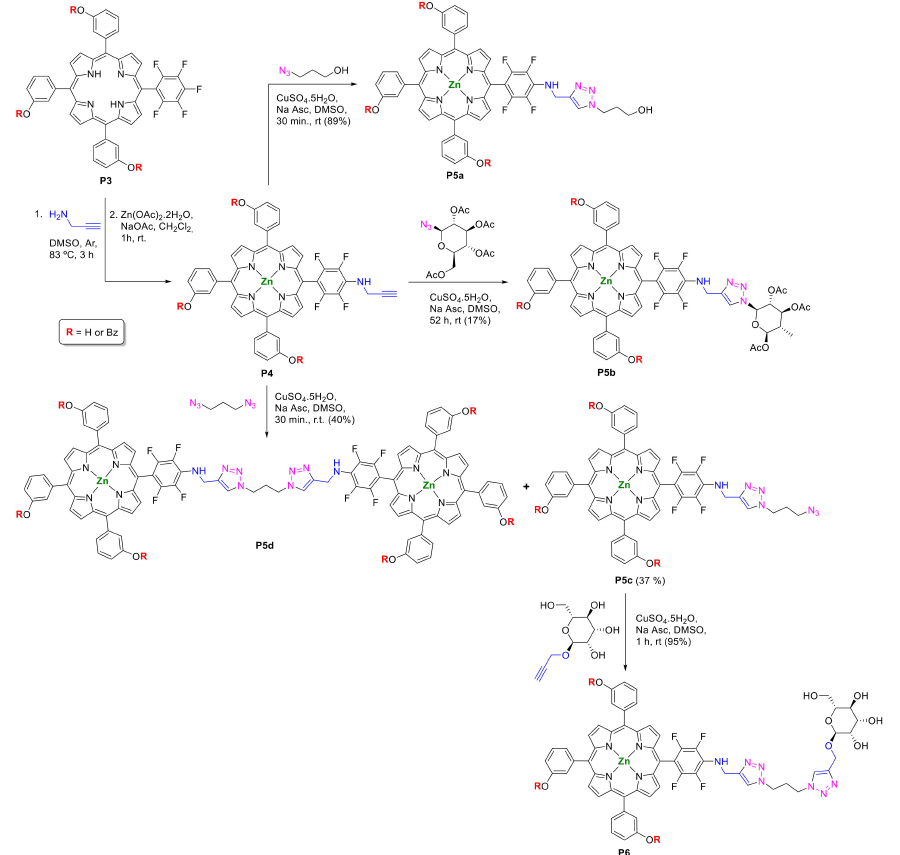
Scheme 3. Porphyrin P3 as useful template for CuAAC